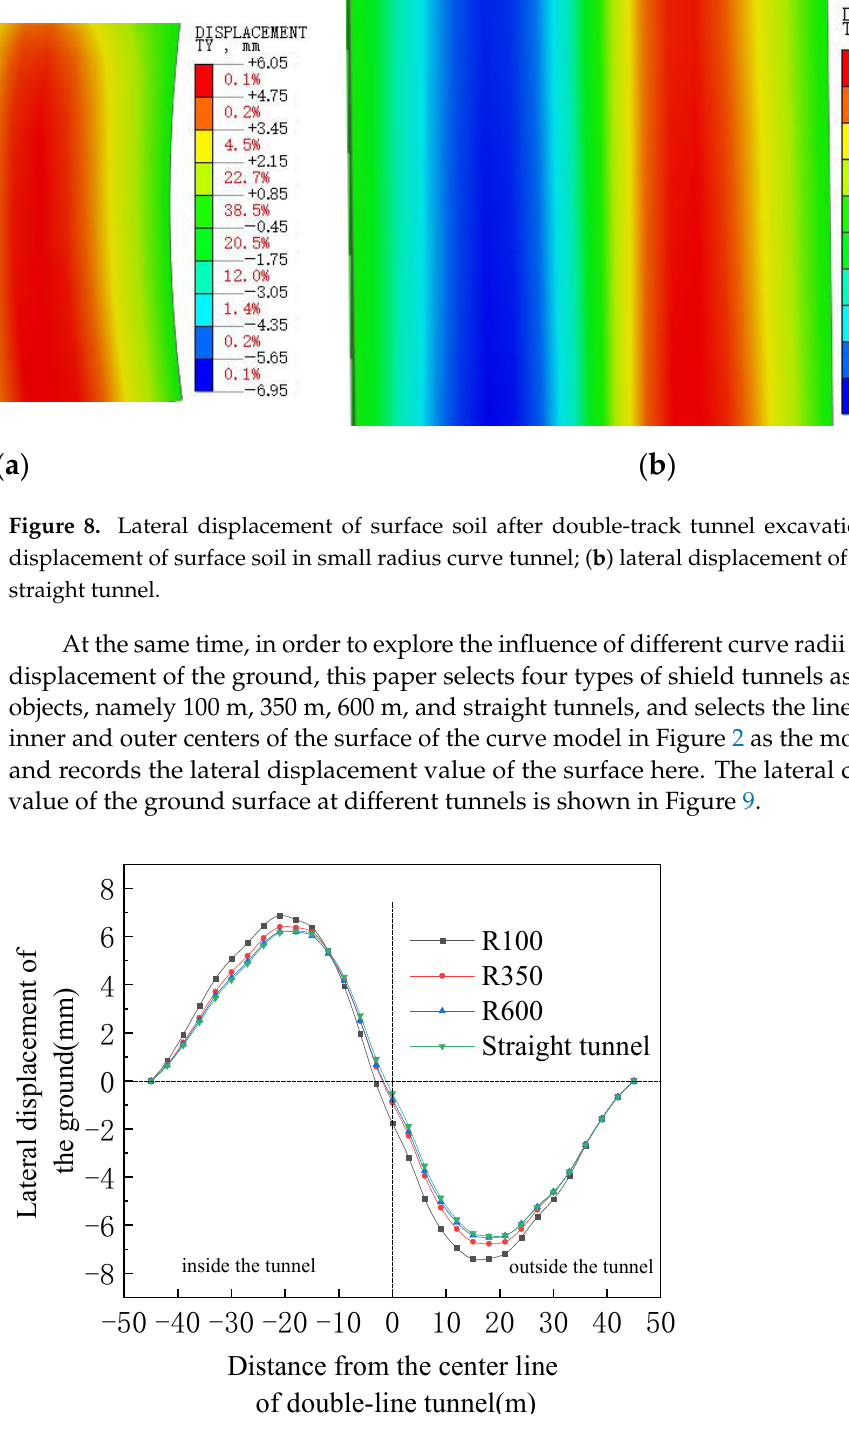
Figure 9. Lateral surface displacement curve after double-track excavation of a small radius curved tunnel.